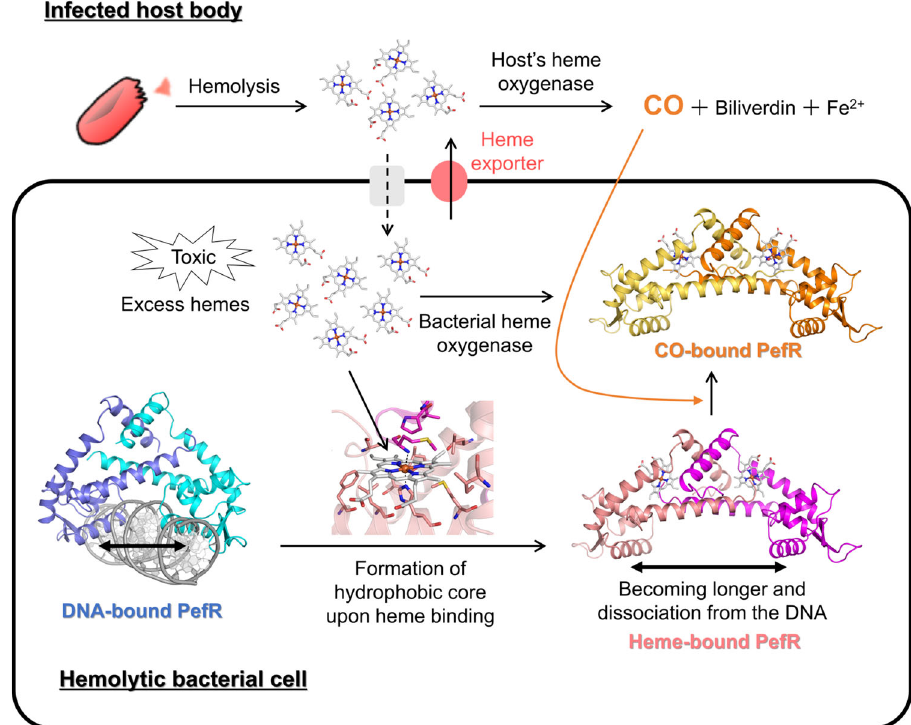
Fig. 8 Schematic diagram of the structure and function of PefR in S. agalactiae . A hemolytic bacterial cell is shown in a black-outlined square. Outside area of the square shows body of infected host. Hemolytic bacteria survive by acquiring hemes from hemoglobin in red blood cells from their animal hosts. To avoid the cytotoxicity of excess heme during hemolysis, PefR act as transcriptional factors to regulate the heme ef fl ux system in response to the cellular heme concentration. Based on crystallographic, spectroscopic, and biochemical studies, the heme coordination to DNA-bound PefR controls structural rearrangement of the DNA-binding domains to dissociate PefR from the target DNA. After dissociating from the target DNA, the heme of holo-PefR can stably bind CO, which is a by-product of heme degradation by heme